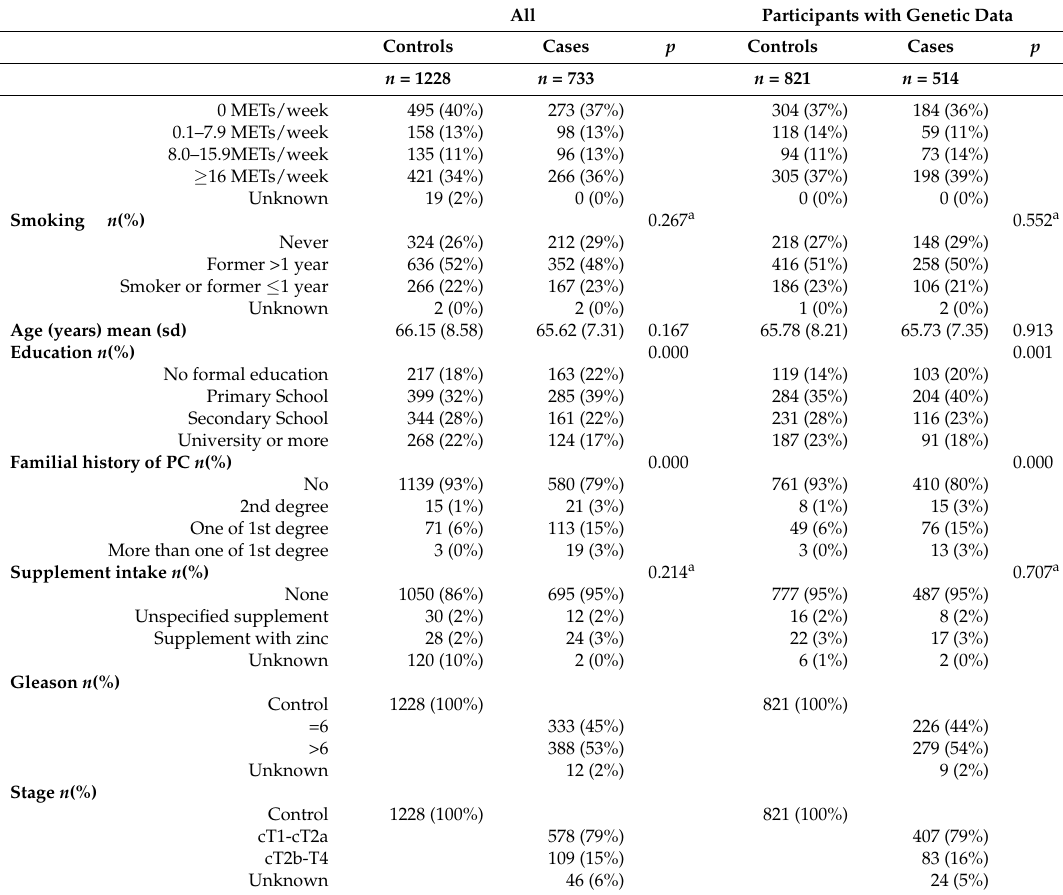
Table 1. Cont. All Participants with Genetic Data Controls Cases